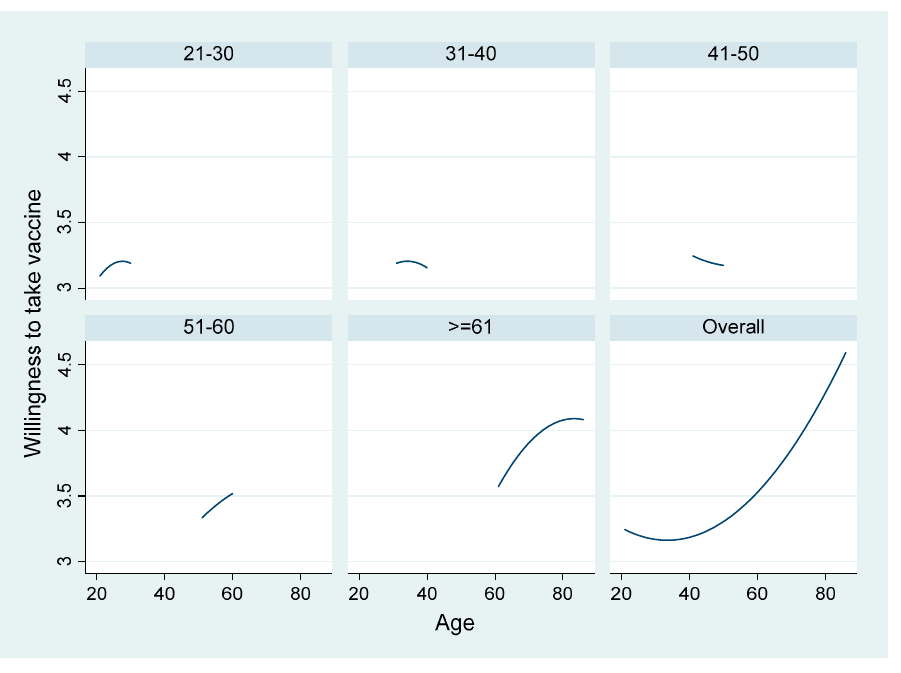
Figure 1. Fitted values of the willingness to take vaccine variable by age group. Int. J. Environ. Res. Public Health 2021 , 18 , x